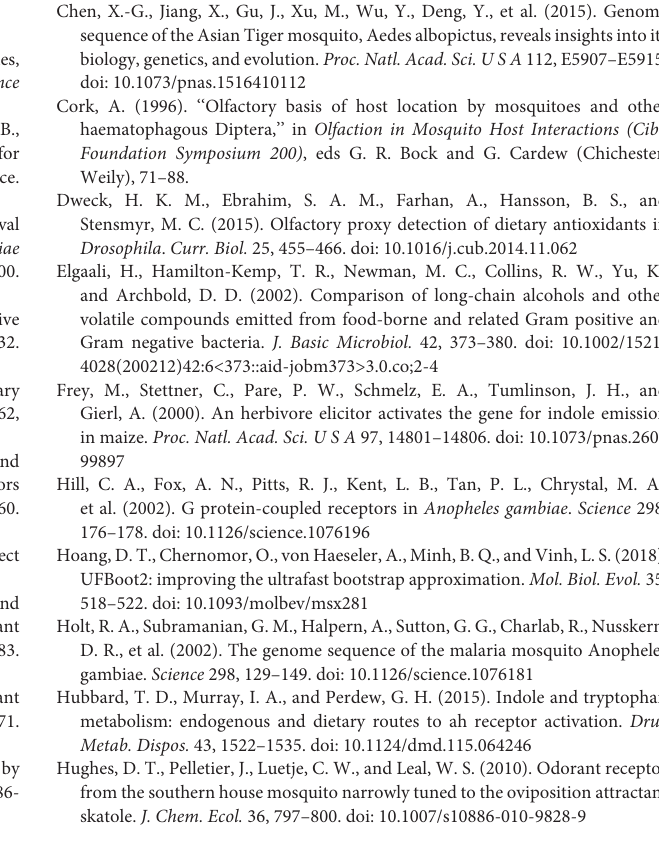
FIGURE S2 | Examples of current traces of AaegOR9-ORco in response to increasing concentrations (Log units) of indole, skatole and indole-3-carboxaldehyde. TABLE S1 | Indole derivatives ranked according to their potency (see Figure 1 ). TABLE S2 | List of cognate pheromone and kairomone receptors deorphanized in the Xenopus laevis and other functional bioassays. TABLE S3 | Accession numbers of indolergic receptors used in Figure 3 ( Ae ., Aedes ; Cu ., Culex ; An ., Anopheles ; To ., Toxorhynchites ; D ., Drosophila